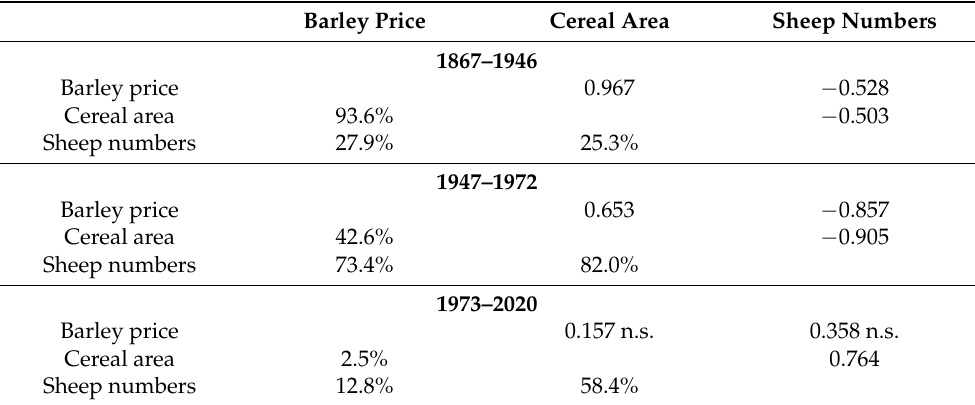
Table 2. Correlation coefficients (upper right quadrant) and r 2 (lower left quadrant) between medium- term cycles for 1867–1946, 1947–1972, and